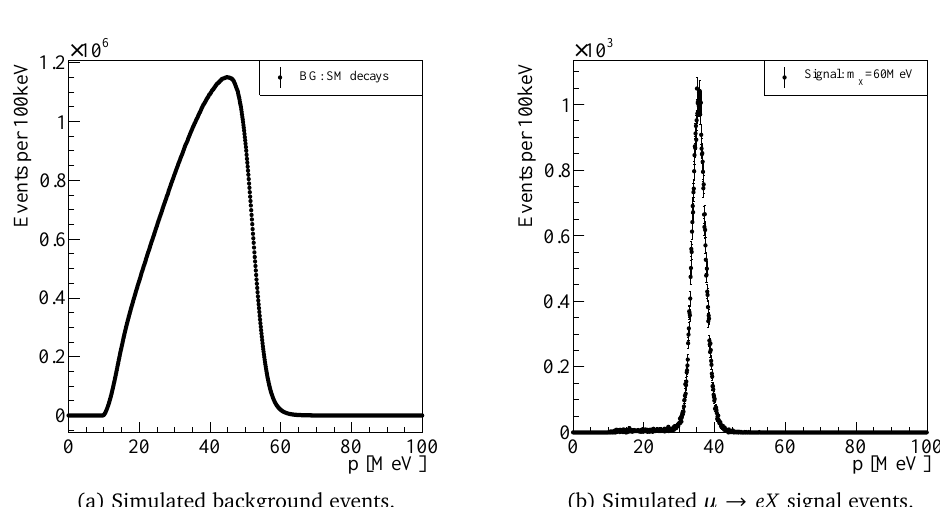
Figure 9: Spectra of the reconstructed momentum of positrons from simulated Stan- dard Model background and µ → eX signal events.